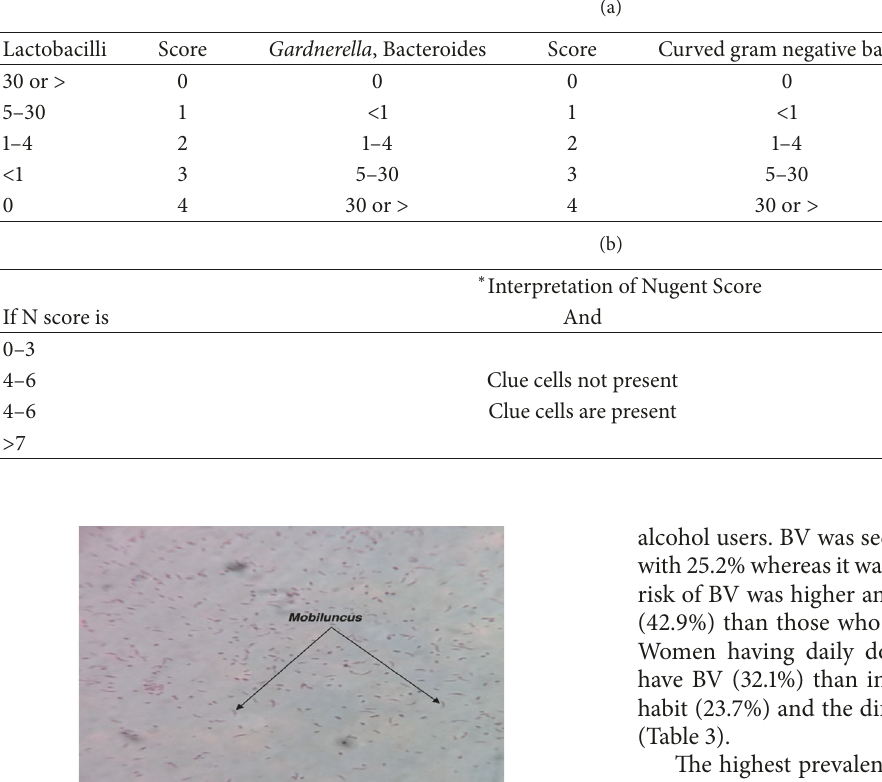
Table 1: Scoring of bacterial morphotype on Gram-stained smear.